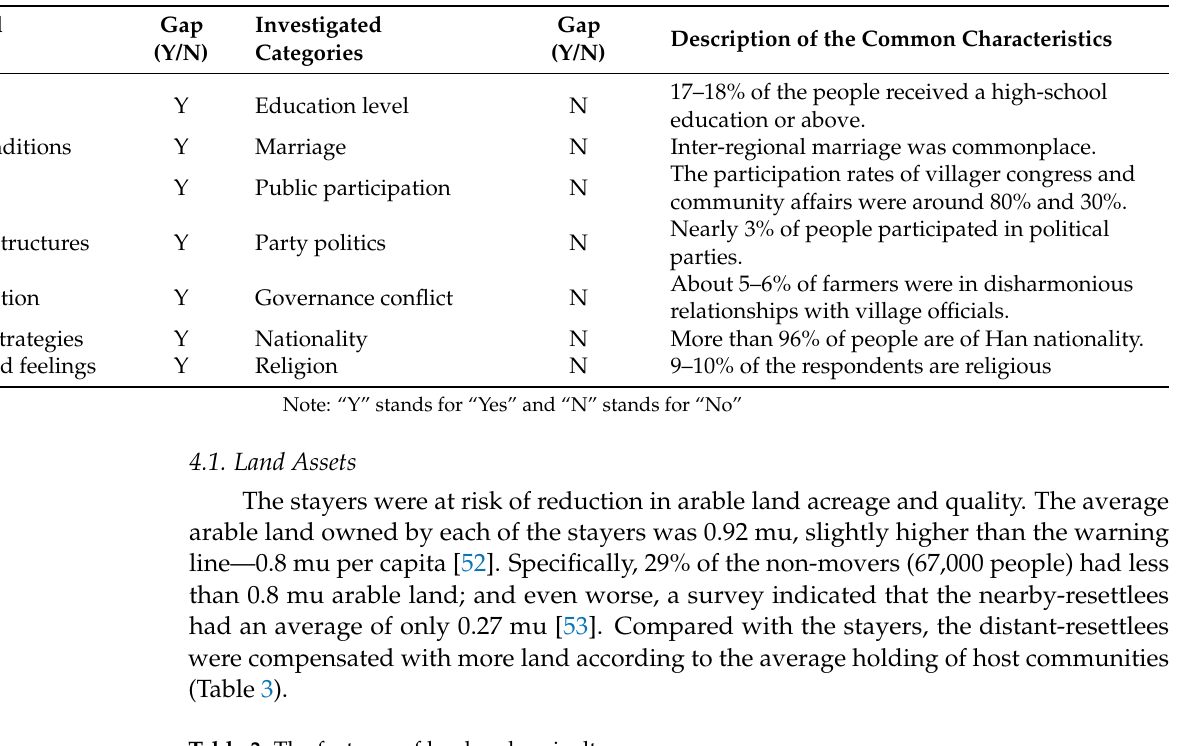
Table 3. The features of land and